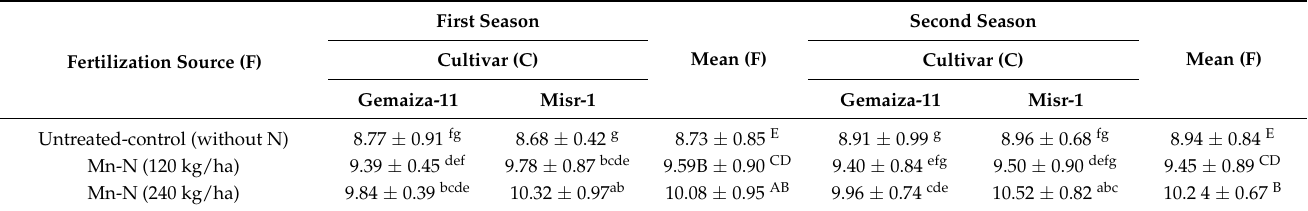
Table 11. Impact of nano- and mineral nitrogen fertilizers on the potassium concentrations (Conc; mg/L) of two wheat cultivars during the 2019/2020 and 2020/2021